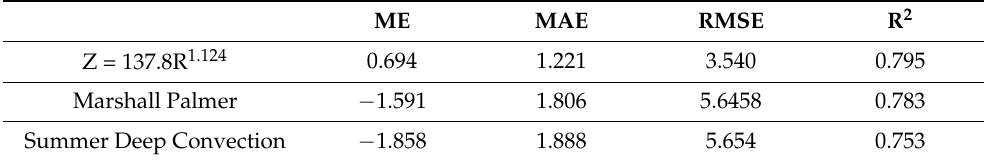
Table 2. Results of statistical testing of composite radar, comparing with three methods. ME MAE RMSE R 2 Z = 137.8R 1.124